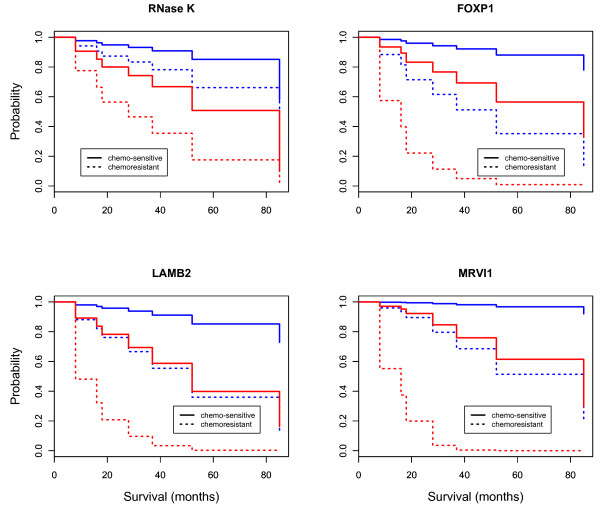
The overall survival estimated by the Cox proportional hazards multivariate model including gene expression and chemo-resistance. The up- and down-regulation is represented by red and blue, respectively.